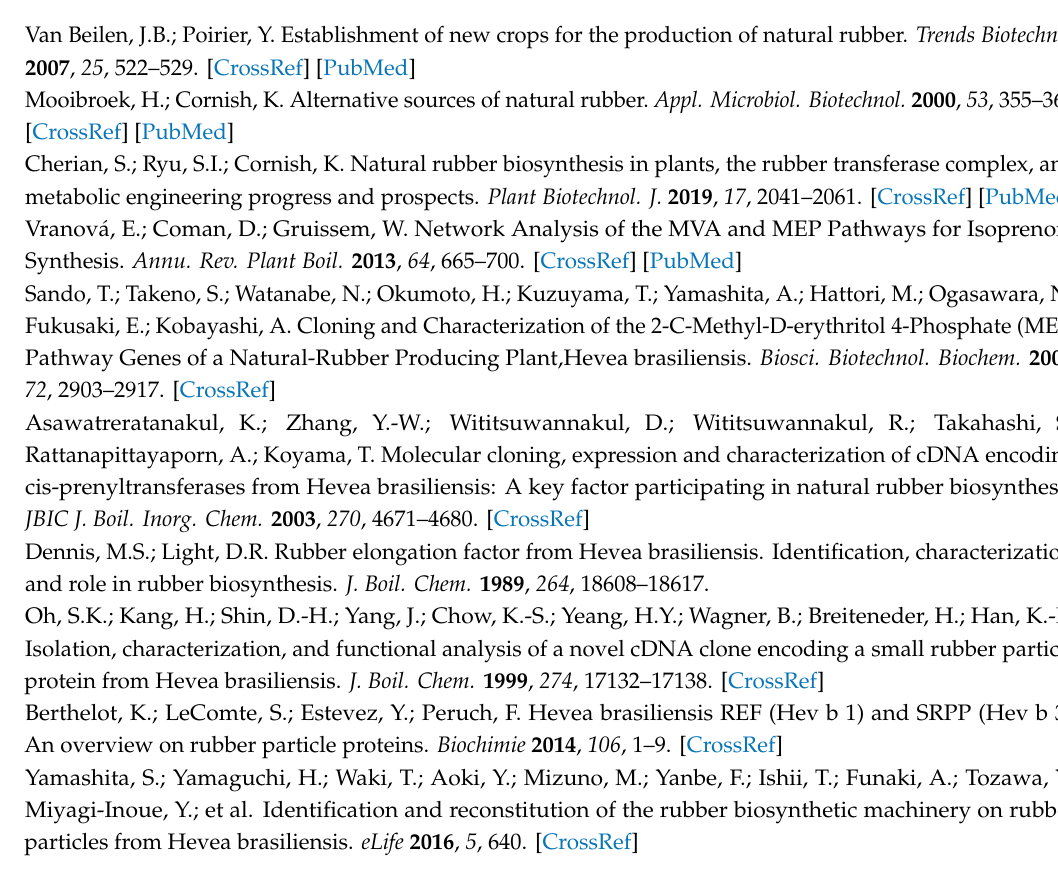
Figure S1: Heatmap of mRNA accumulation of 10 selected TF genes in tissue-specific RNA-seq analysis, Figure S2: Detection of recombinant TF proteins by SDS-PAGE and Western blot analysis; Table S1: Primers used in this work, Table S2: List of DEGs, Table S3: Rubber biosynthesis-related genes, Table S4: TFs included in DEGs, Table S5: List of candidate genes targeted by each